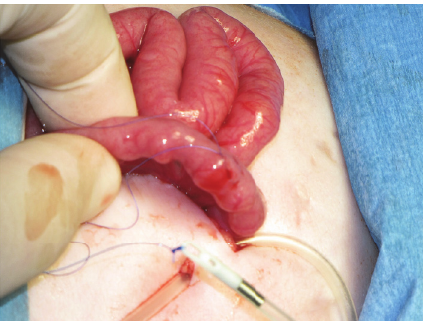
Figure 1: Placement of a purse string suture at antimesenteric aspect of the second jejunal loop. The feeding tube attached to a guide thread was introduced into the abdominal cavity (girl aged 2 months; patient 8).